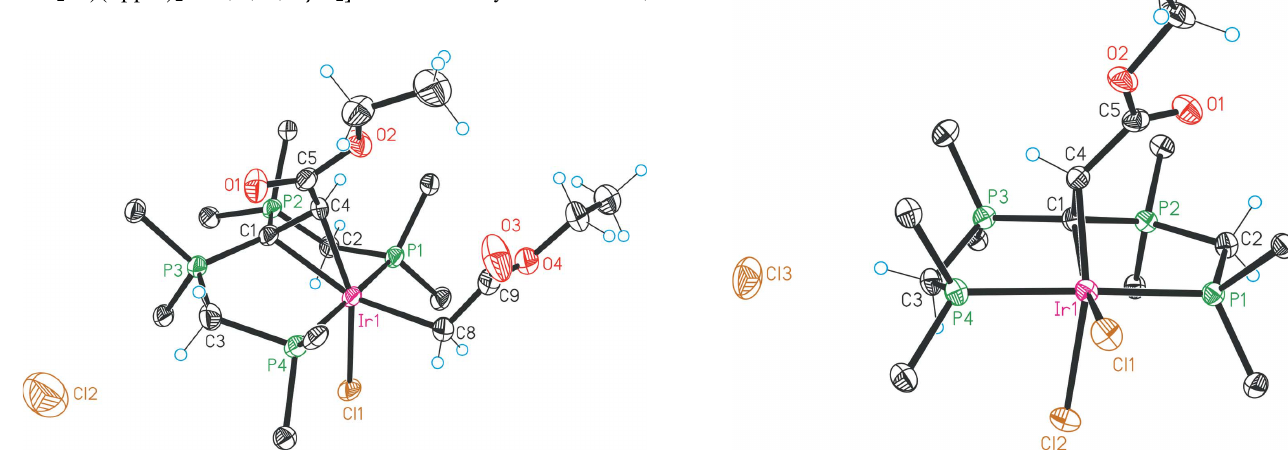
Figure 4 Molecular structure of the complex cation in 6 and the counter-anion. Displacement ellipsoids are drawn at the 30% probability level. For clarity, only the ipso carbon atoms of the phenyl groups are presented and the solvent molecules are